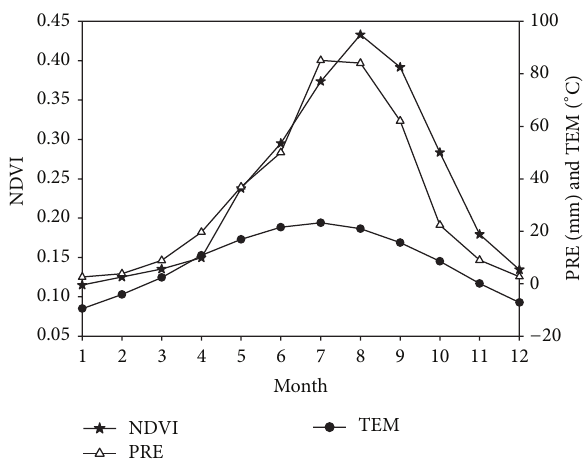
Figure6:ThemonthlyNDVI,precipitation,andtemperatureonthe northern Loess Plateau from 1998 to